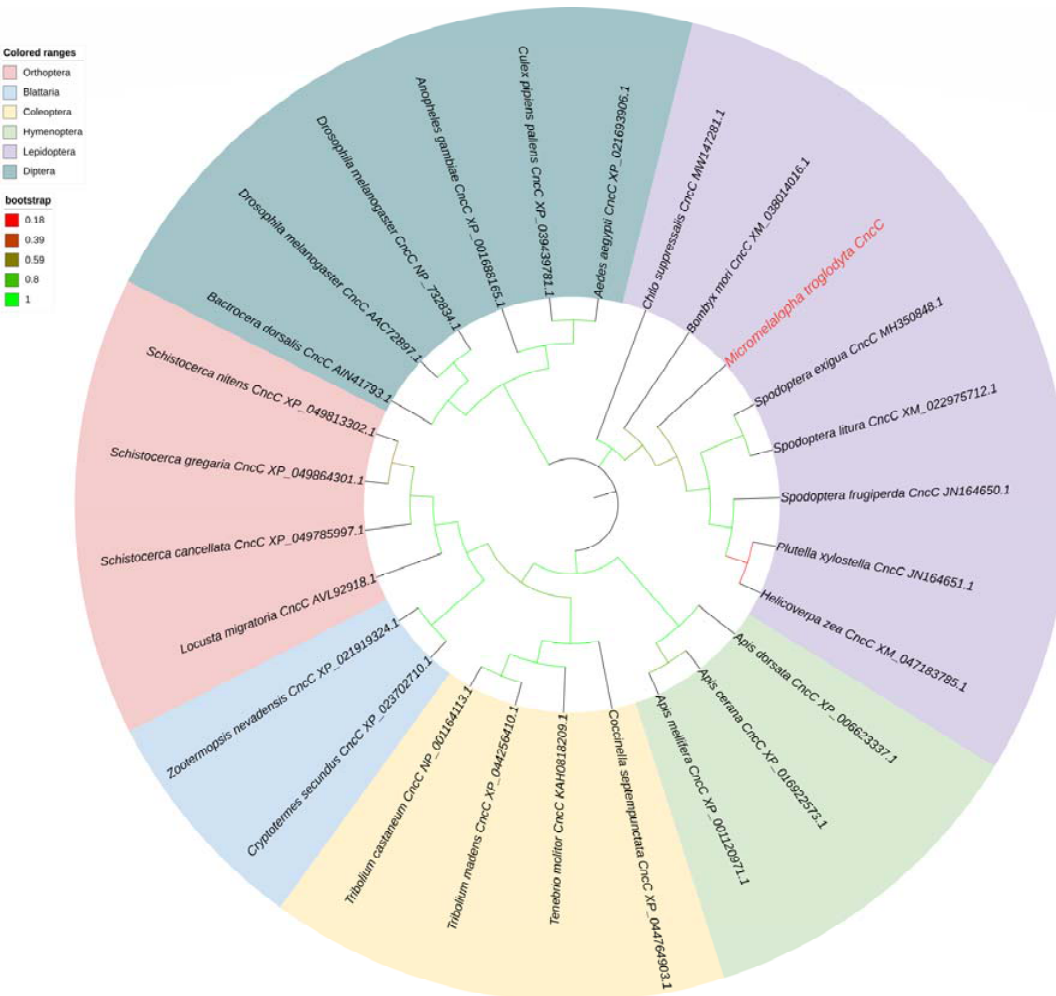
Figure 4. Phylogenetic analysis of the CncC sequences of several insect species. The CncC gene name was shown as the Latin name of the species, CncC and the NCBI gene accession number, and the M. troglodyta CncC was marked in red and bold. The branches for Lepidoptera, Diptera, Blattodea, Coleoptera, Hymenoptera, and Orthoptera CncCs were shaded in different colors, and branch colors represented bootstrap values.